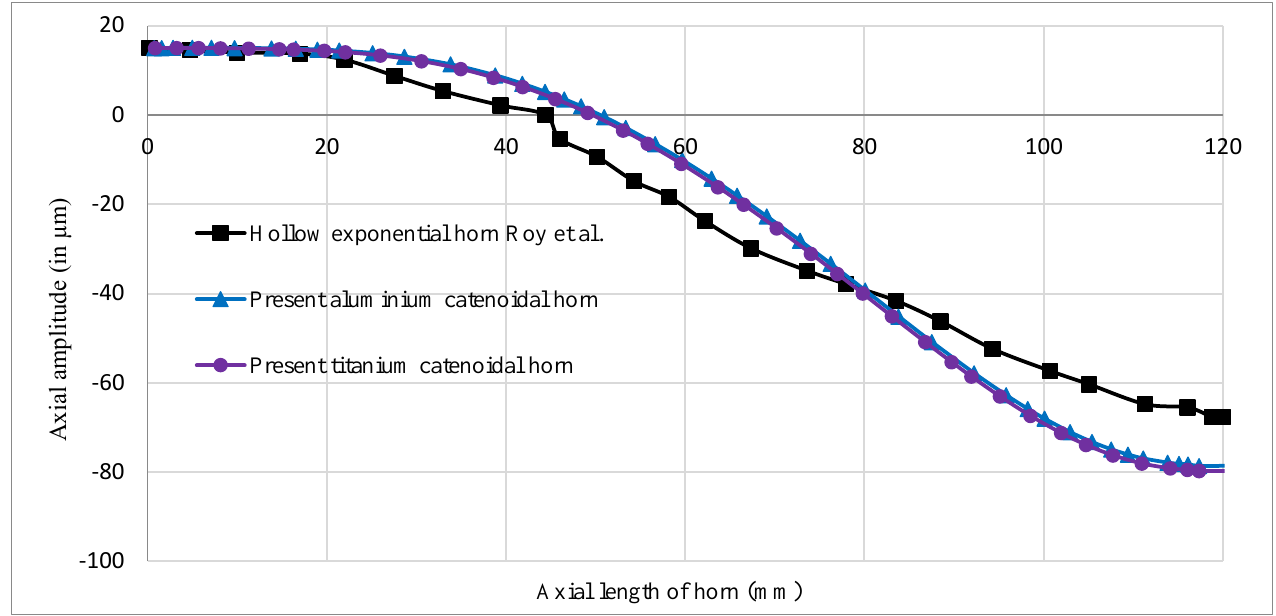
Figure 9. Amplitude variation of various